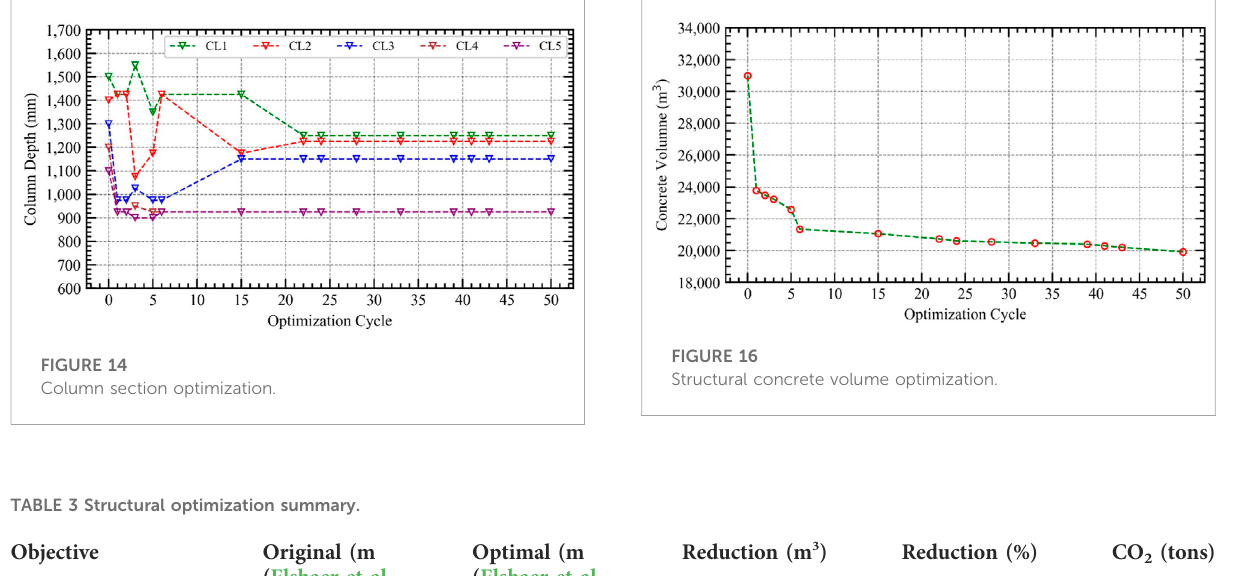
FIGURE 13 Core-wall section optimization.